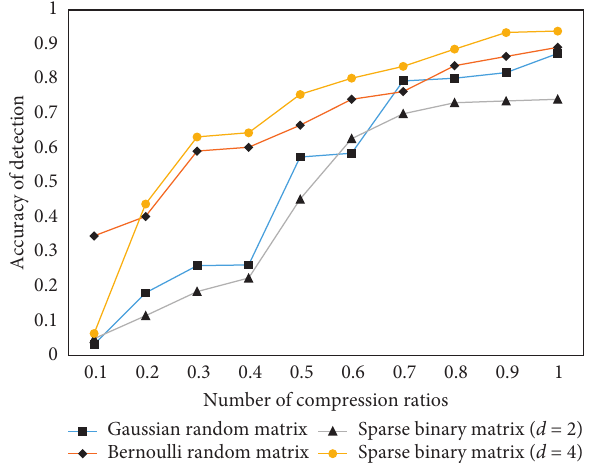
Figure 9: Action recognition rate under different random pro- jection matrices under different compression ratios.